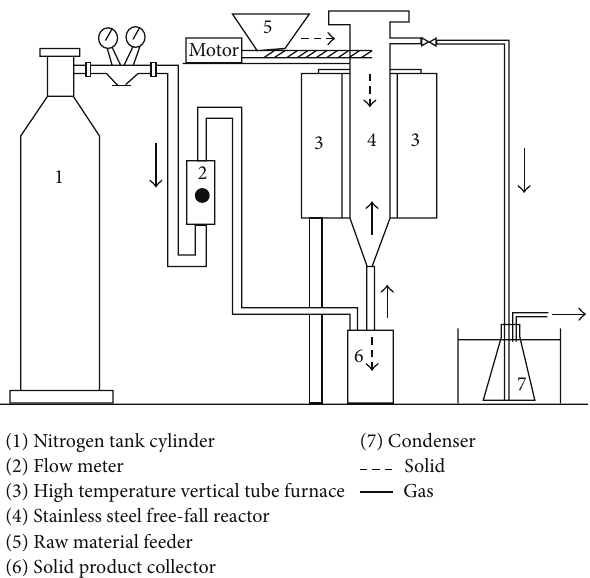
Figure 2: Schematic diagram of the free-fall reactor